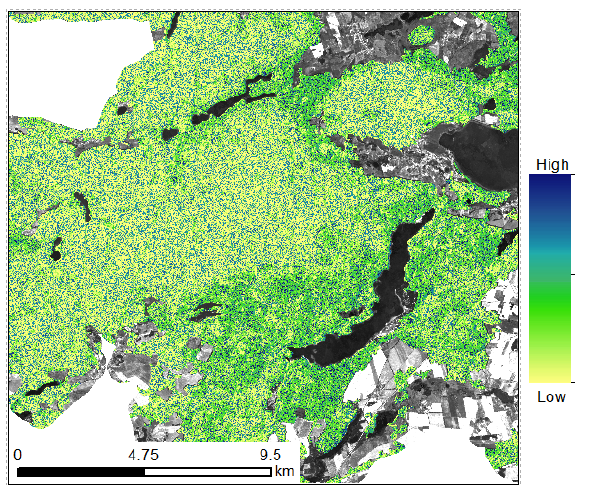
Figure 11: Standard deviation of diameter at breast height (DBH std) in forests, modelled with Sentinel-1 multitemporal